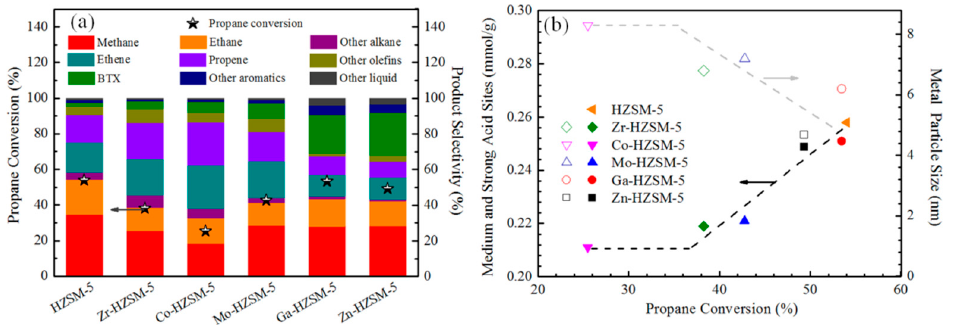
Figure 6. ( a ) Propane conversion and product selectivity over the catalysts; ( b ) the impact of medium and strong acid sites on propane conversion.